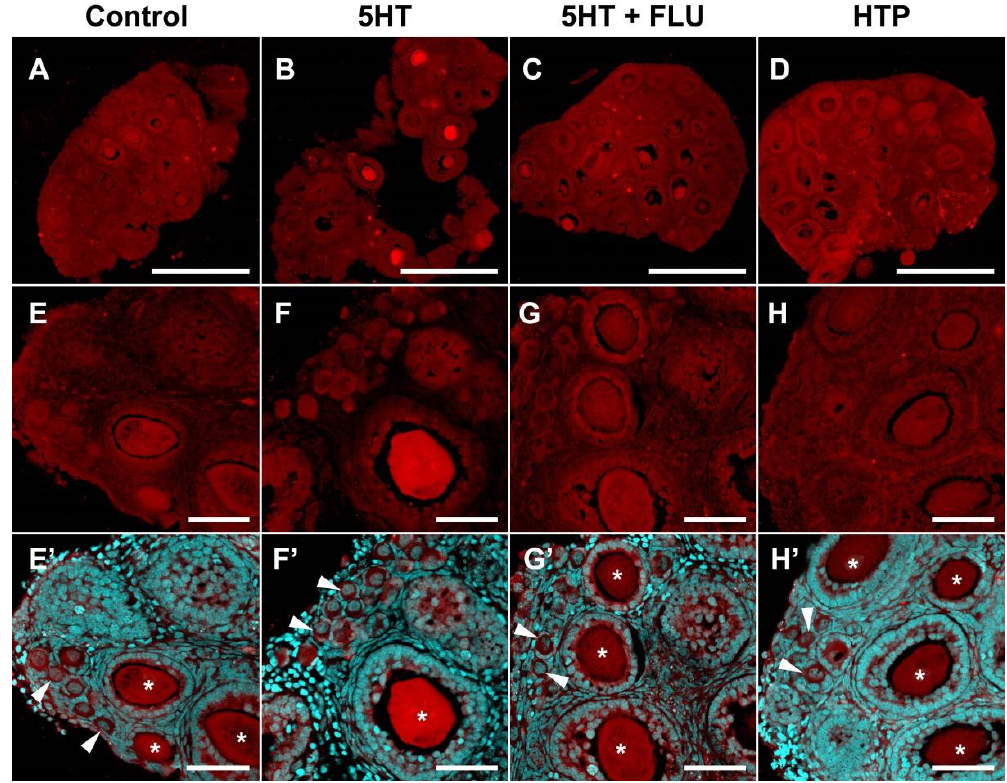
Figure 5. Functional activity of uptake and synthesis of serotonin in the prepubertal (14 dpp) mouse ovary. ( A , E ) Control. ( B , F ) Two-h incubation with serotonin (5HT) (1 µ M). ( C , G ) Two-h incubation with 5HT (1 µ M) with previous addition of fluoxetine (FLU) (10 µ M). ( D , H ) Two-h incubation with 5-hydroxytryptophan HTP (10 µ M). ( E’ – H’ ) Images merged with nuclear staining. Twenty- µ m cryosections were stained for serotonin (red false colour) and nuclei were dyed with DAPI counterstain (cyan false colour). White arrowheads point to primordial follicles. Asterisks mark oocytes in growing follicles. Scale bars: ( A – D ) 500 µm; ( E – H ) 50 µm.